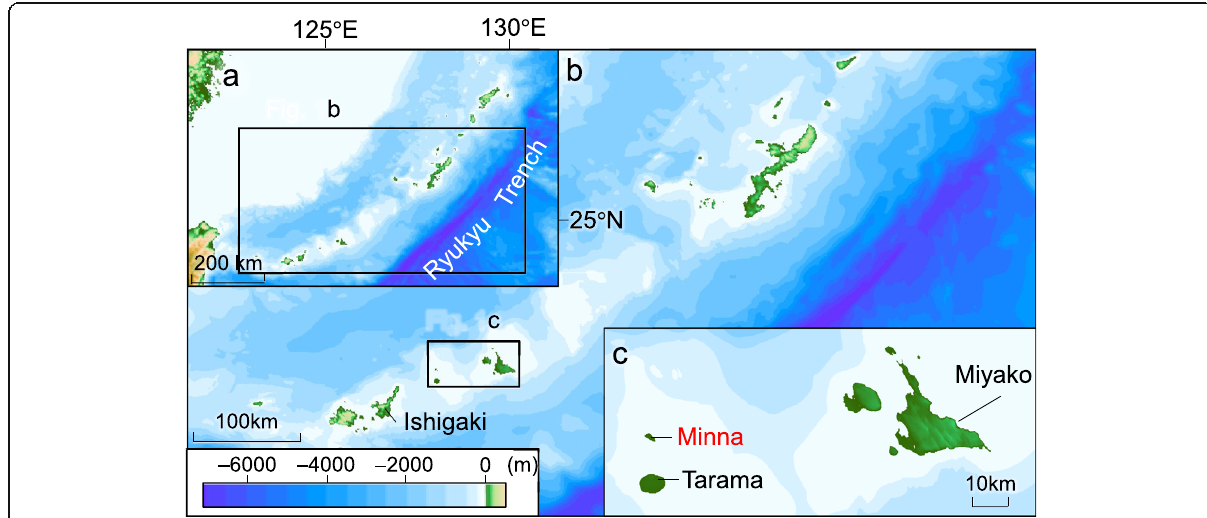
Fig. 1 Study area maps: a Ryukyu arc and trench; b Miyako Islands and Yaeyama Islands; c Miyako Islands